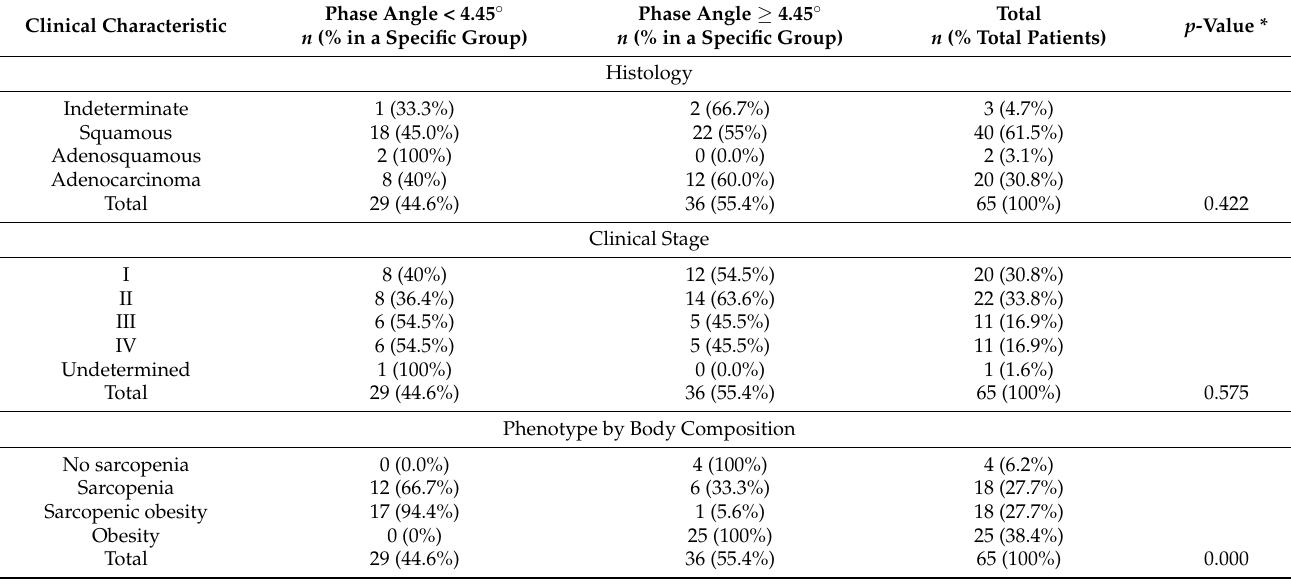
Table 1. Clinical characteristic of uterine cervical cancer